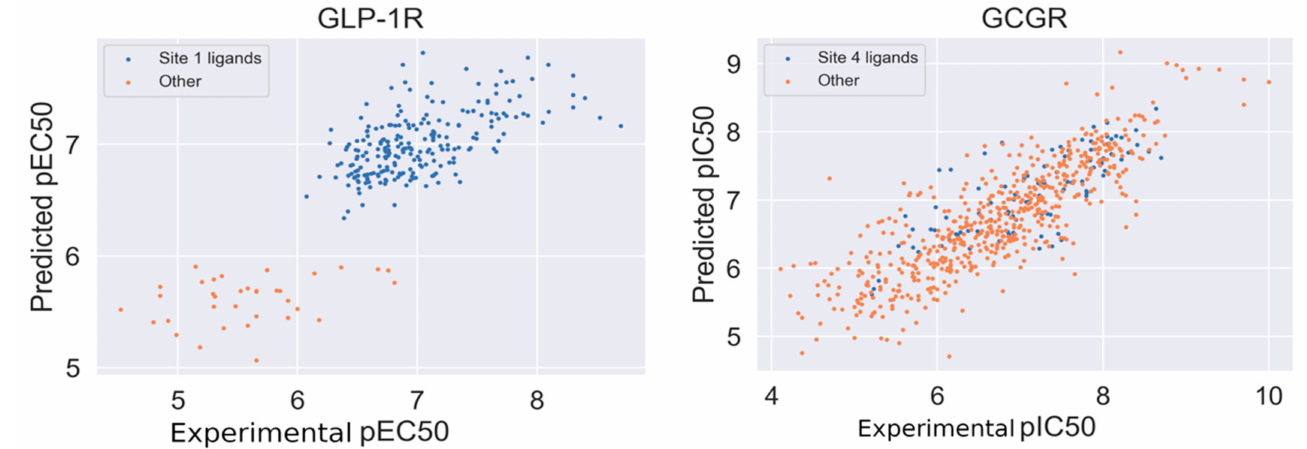
Figure 5. Autocorrelation plots of experimental vs. predicted values of pEC 50 (GLP-1R) and experimental vs. predicted values of pIC 50 (GCGR). Correlation coefficient equal to 0.81 (GLP-1R) and 0.83 (GCGR).